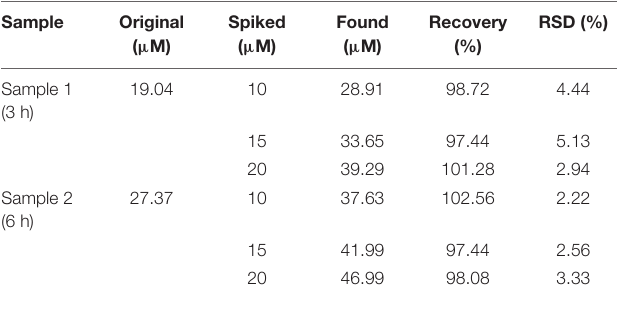
TABLE 1 | Analytical results of Hx and spiked Hx in fish extracts.